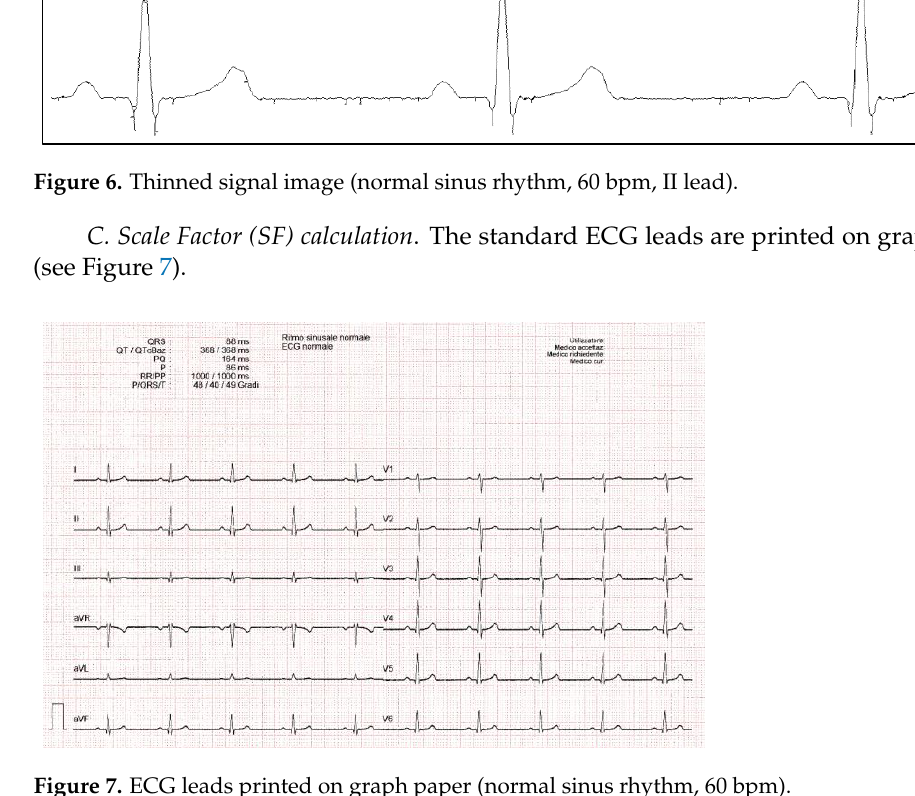
Figure 7. ECG leads printed on graph paper (normal sinus rhythm, 60 bpm).